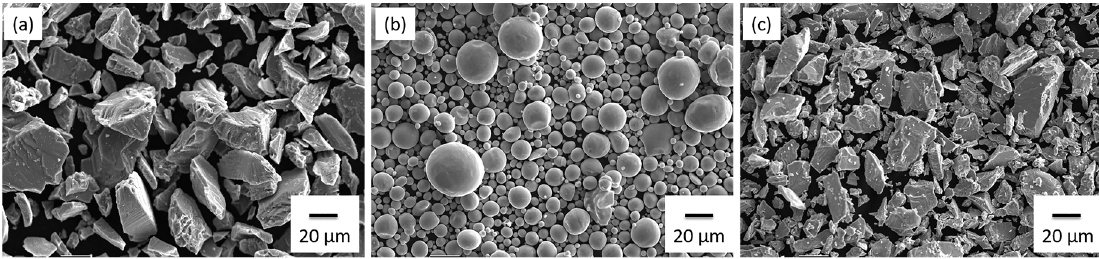
Figure 1. Morphology of as-received ( a ) titanium hydride, ( b ) pure titanium and ( c ) pure niobium